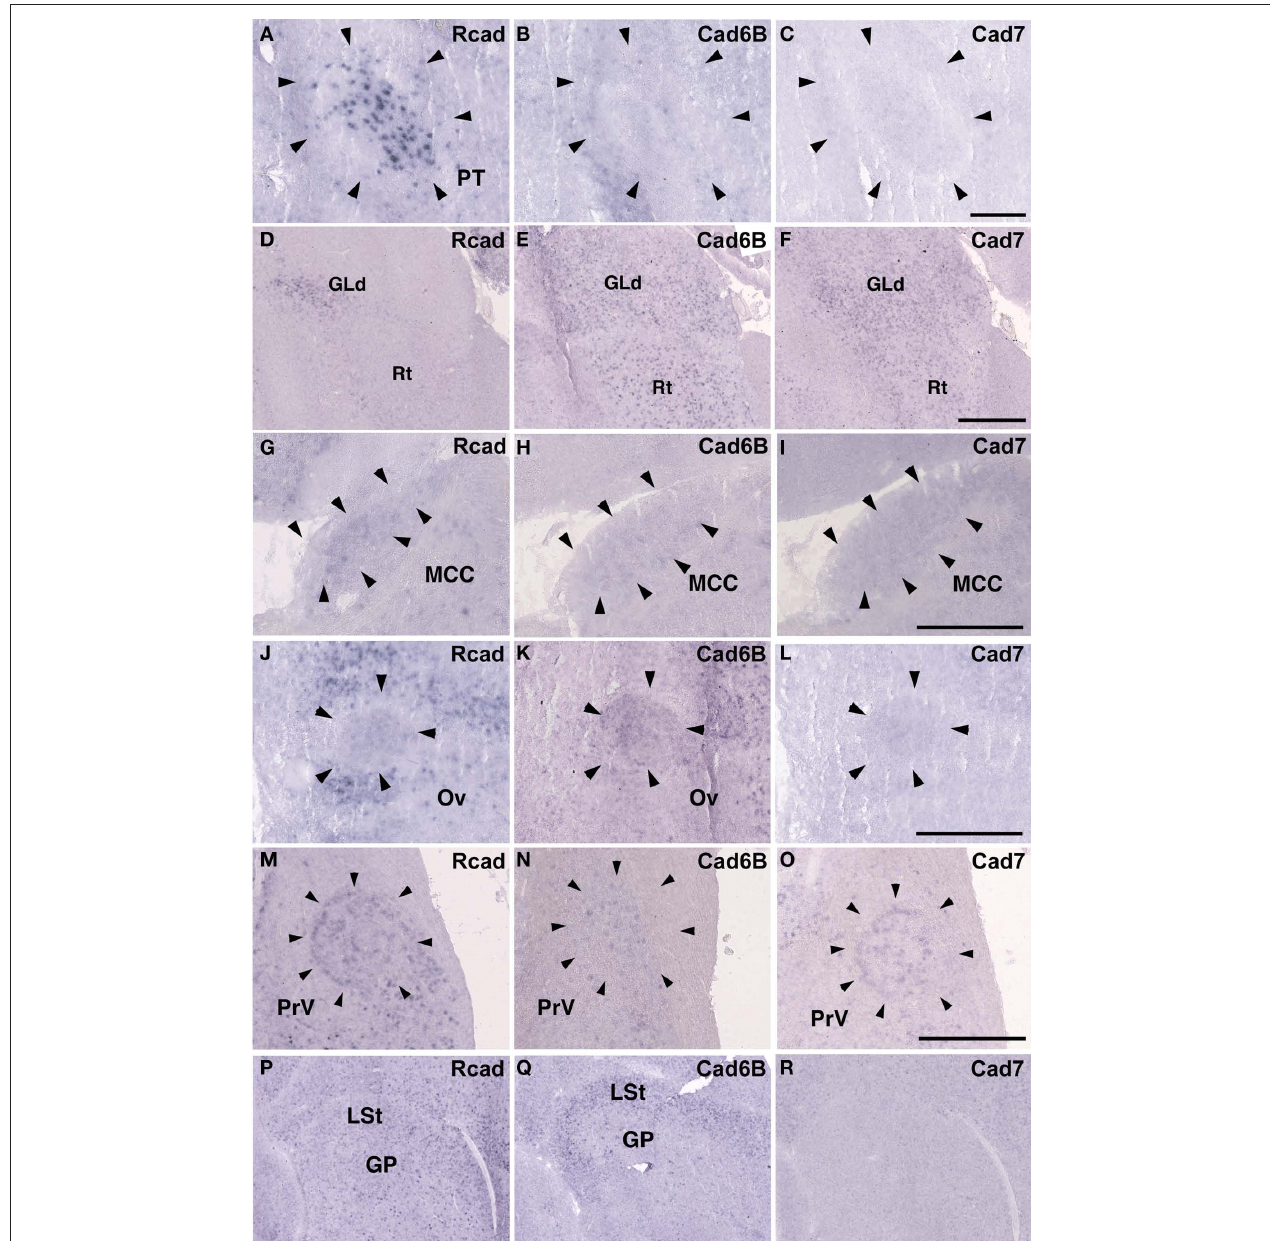
Figure 13 | Cadherin expressions in non-vocal areas of ring dove. In situ hybridization for Rcad (A,D,g,J,M,P) , cad6B (B,e,H,K,N,Q) , and cad7 (C,F,i,L,O,r) . Cadherin expressions in PT (A–C) , Rt (D–F) , MCC (g–i) , Ov (J–L) , PrV (M–O) , and GP (P–r) . Scale bars are 1 mm (F,i,L,O,r) , and 500 μm